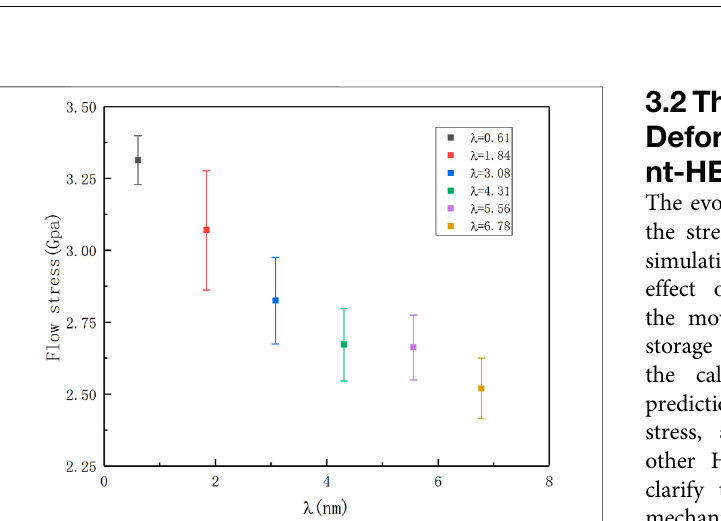
Frontiers in Materials |